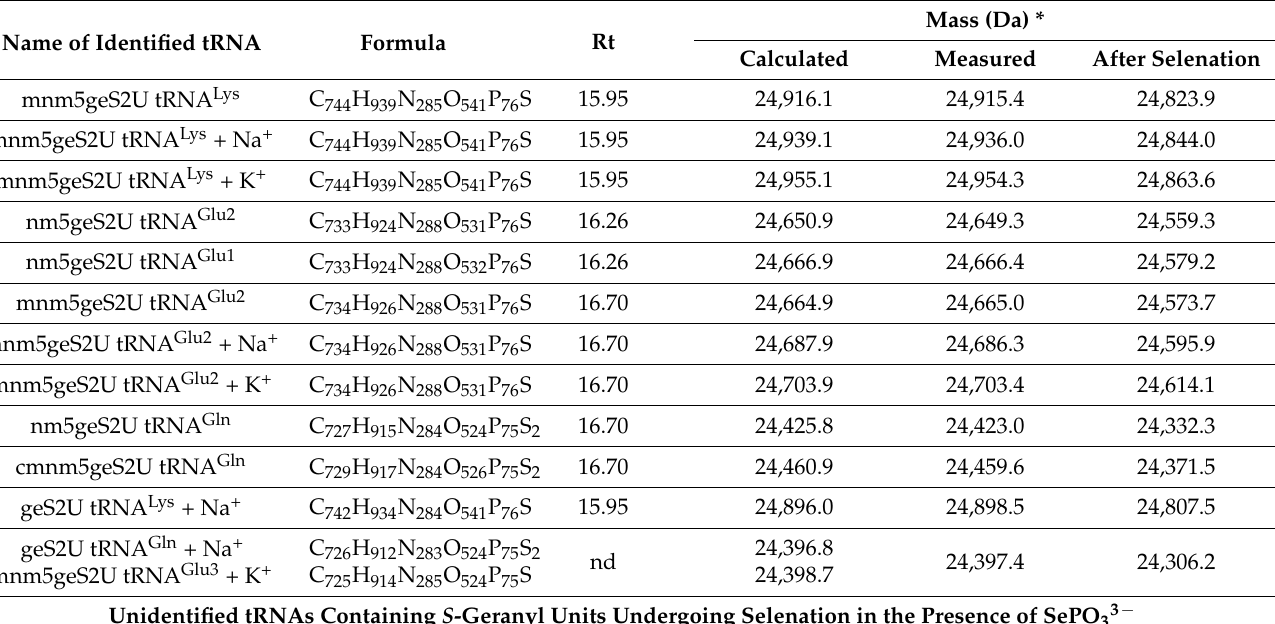
Table 4. Summary of the identification of full-length tRNAs that were associated with MBP–SelU protein, nd—not